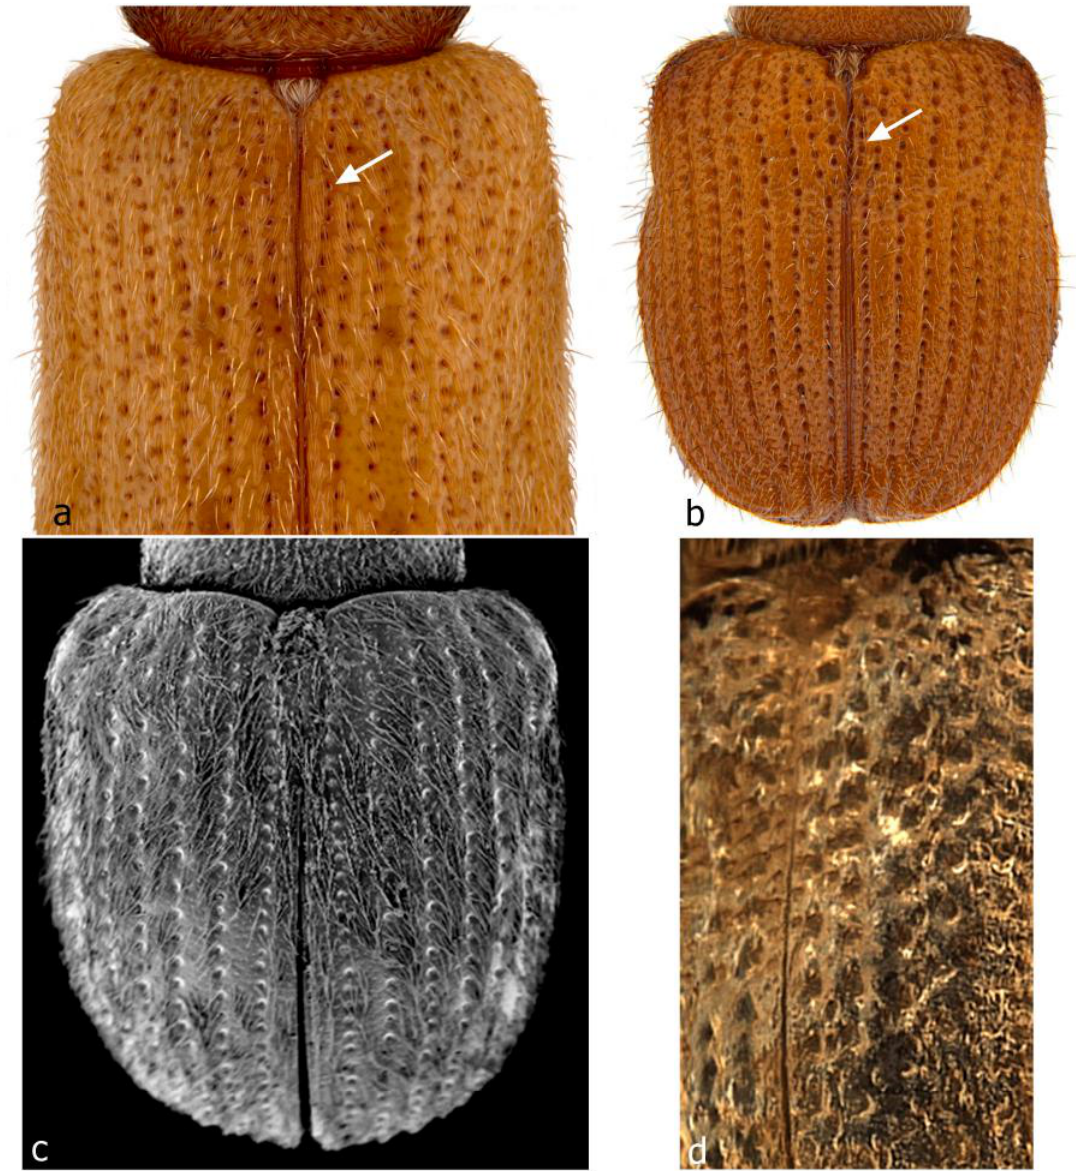
Figure 9. Elytral striae in extant and Burmese amber weevils. Scutellary strioles present (arrow), Aragomacer leai (Nemonychidae) ( a ); scutellary strioles present (arrow), Rhodocyrtus cribripennis (Attelabidae) ( b ); all striae complete (scutellary strioles absent), Car cf. condensatus (Caridae) ( c ); all striae complete (scutellary strioles absent), Louwiocis megalops (Mesophyletidae) ( d ).